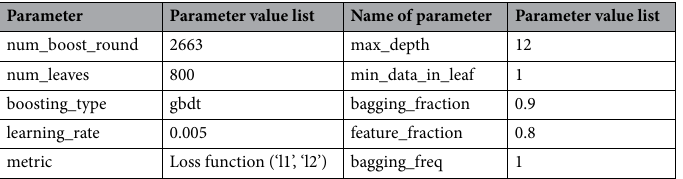
Table 5. Key parameter Settings of LightGBM prediction